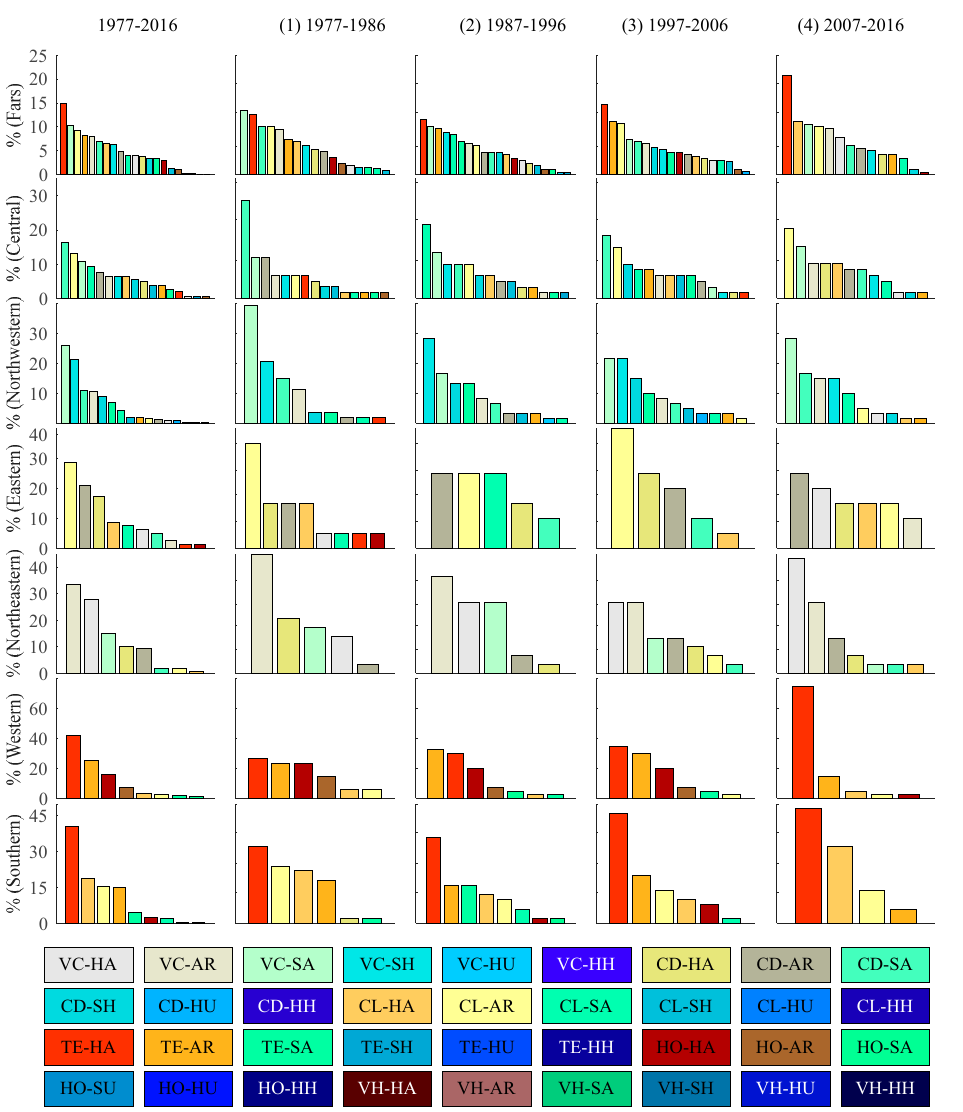
Figure 3. Climate variations in different periods in the six regions of Fars province, according to the Emberger climate classification. The y-axis shows percentages of occurrence of different climate types.